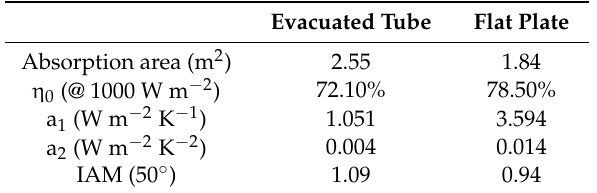
Table 3. Main technical characteristics of the solar collectors (Kloben Industries, 2017).